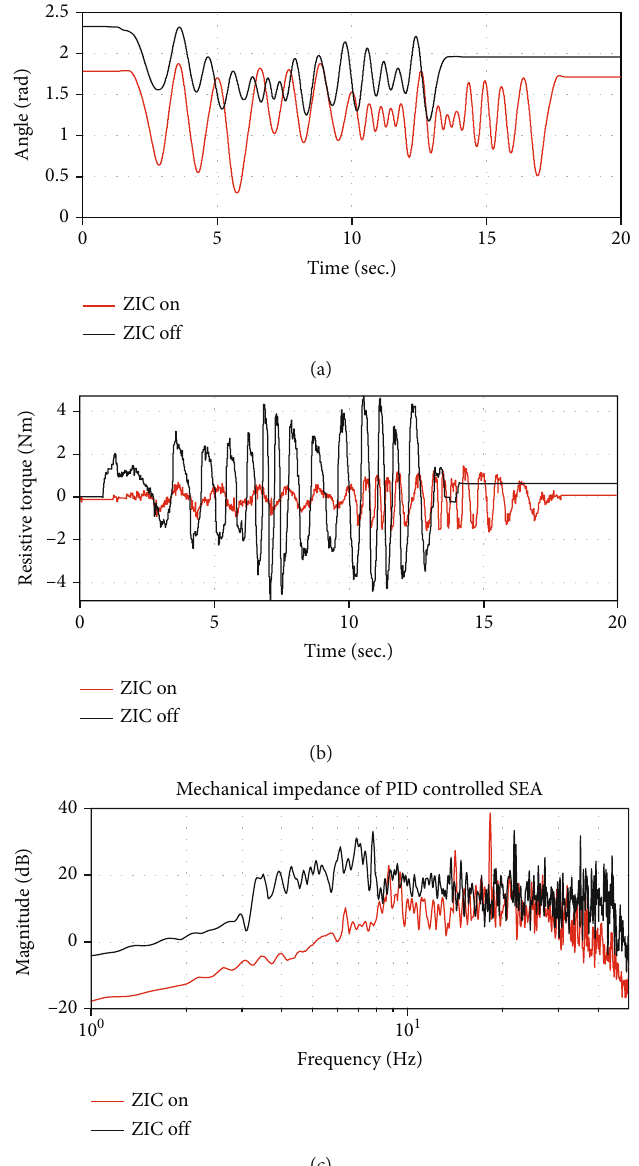
Figure 2: Reduced mechanical impedance (resistive force) on the knee joint of the robotic exoskeleton after applying ZIC: (a) an arbitrary motion applied to the joint; (b) a resistive force against motion inputs; (c) a mechanical impedance de fi ned as the magnitude of the ratio of the resistive force to the joint velocity in the frequency